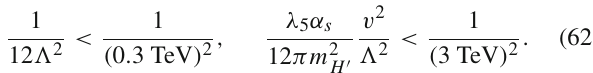
as mentioned in footnote 7, before it reaches the